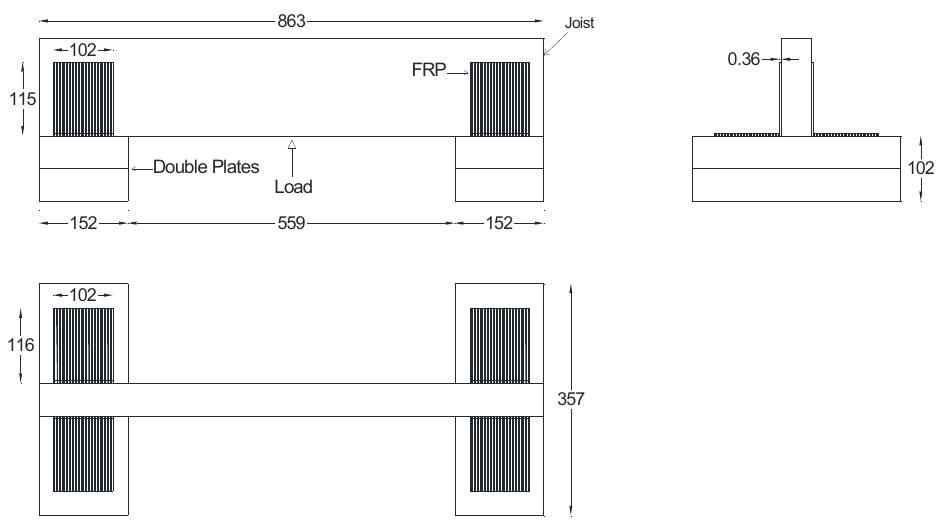
Figure 3. Setup of roof-to-wall connection for uplift test (all dimensions are in mm).